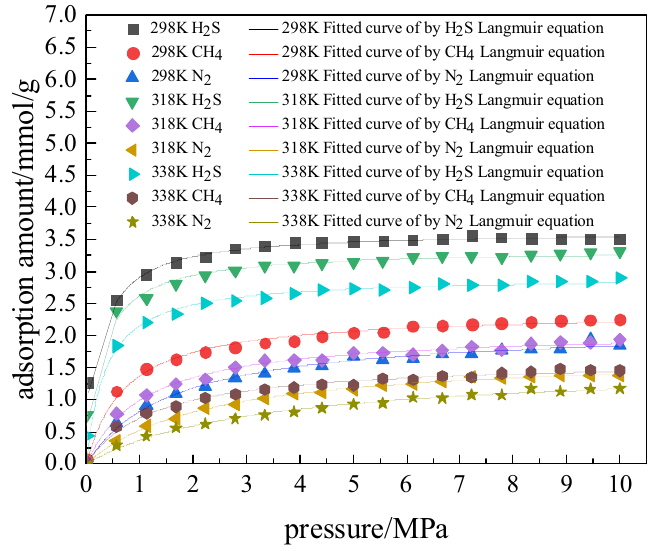
Figure 3. Adsorption isotherms of H 2 S, CH 4 and N 2 at different temperatures.